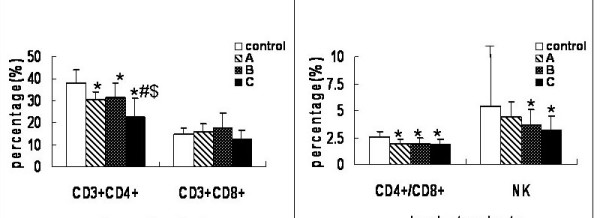
Alteration of peripheral lymphocyte subsets and NK cells with tumor progression. T lymphocyte subpopulations were quantitated by flow cytometry. Samples were prepared by adding 5 μl of fluorescent monoclonal antibody of CD3, CD4, CD8 and CD161a to 100 μl of heparinized whole blood. CD3+CD4+ (T helper cell) and CD3+CD8+ (T suppressor cells) were measured and natural killer (NK) was recognized as CD3-CD161a+. Values (except for CD4+/CD8+) represent percentage (%). Data are expressed as averages and SD. * means compared with control group, P < 0.05. # means compared with group A, P < 0.05. $ means compared with group B, P < 0.05.